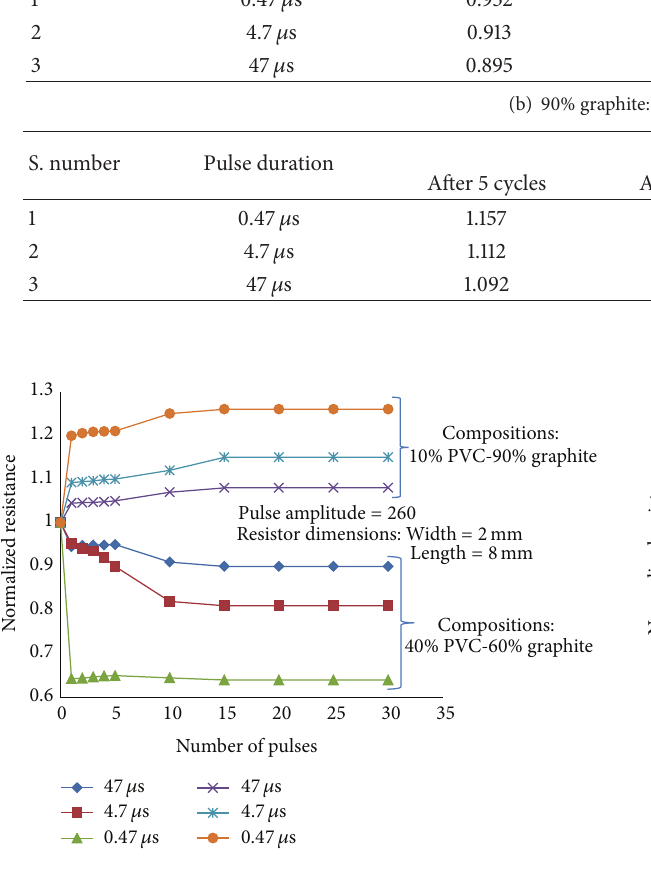
Figure 4: Normalized resistance variation with number of pulses for different pulse durations.